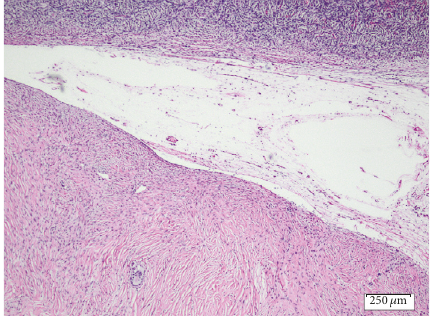
Figure 2: Left ovary (cortex on top) containing a fibrotic focus with a single multinucleated giant cell. (Hematoxylin and Eosin, × 4).